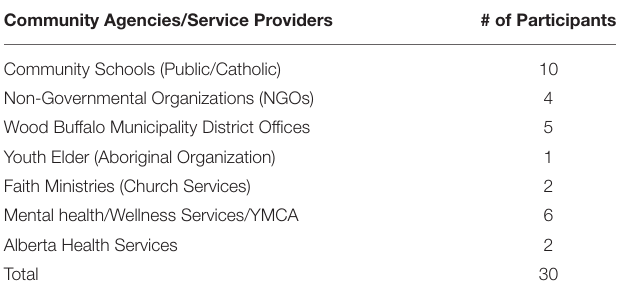
TABLE 1 | Demographic information for interview participants in Fort